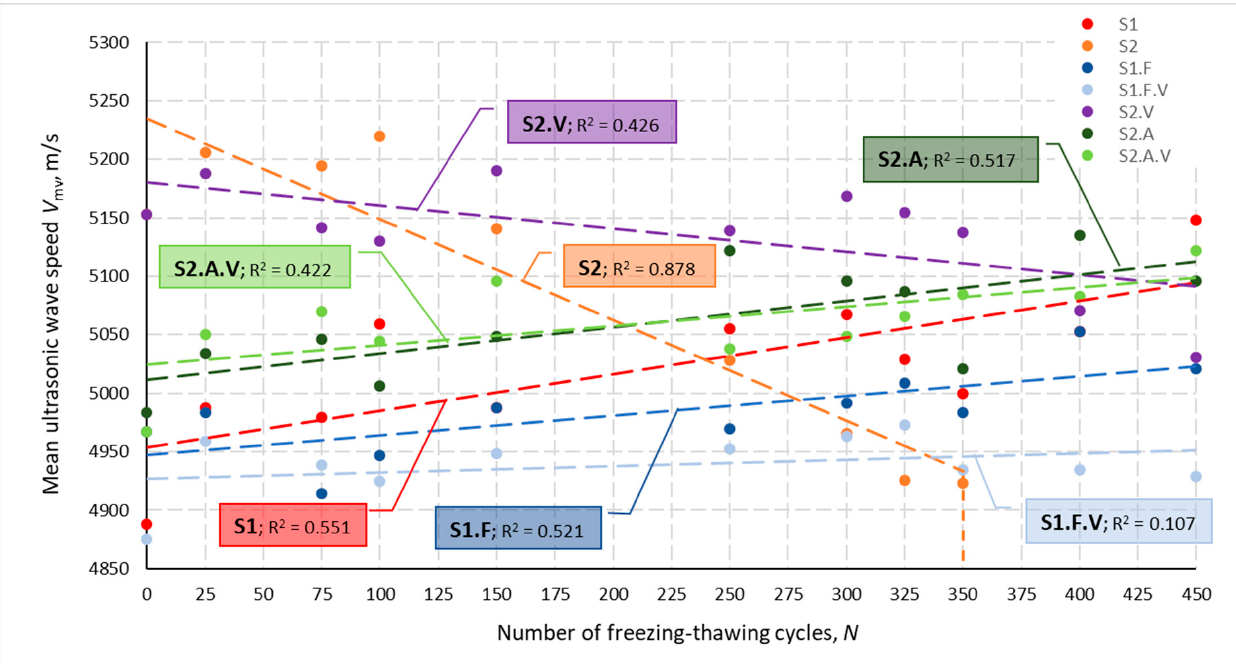
Figure 1. Measured ultrasonic wave velocity for individual concrete types depending on the number of freezing and thawing cycles.